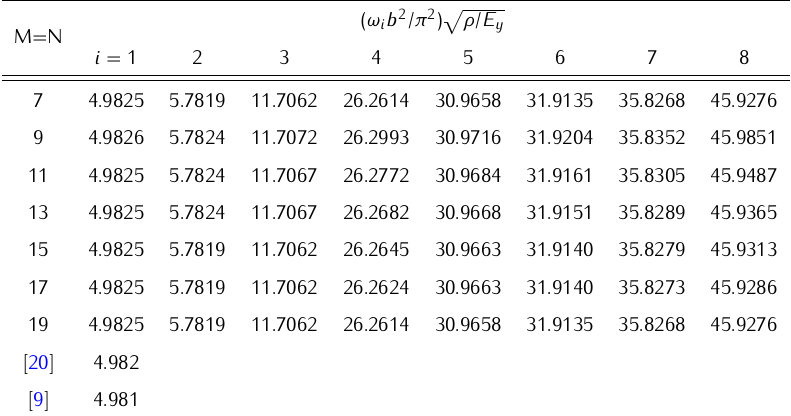
Table 3. Convergence study with respect to the results given by [20] and [9] for a cross-ply laminates ( for Boundary condition i.e.